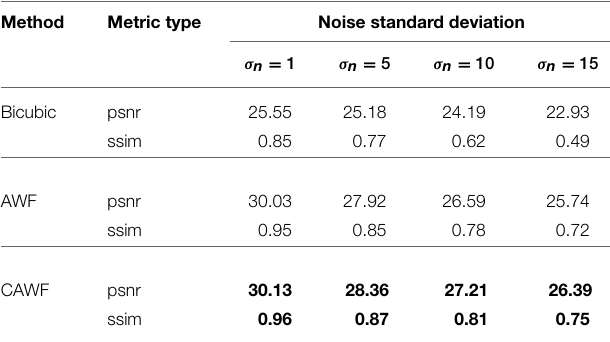
TABLE 5 | Quantitative performance of the bicubic, the AWF and the CAWF outputs for the Lighthouse image when L = 3 , P = 9 and four levels of